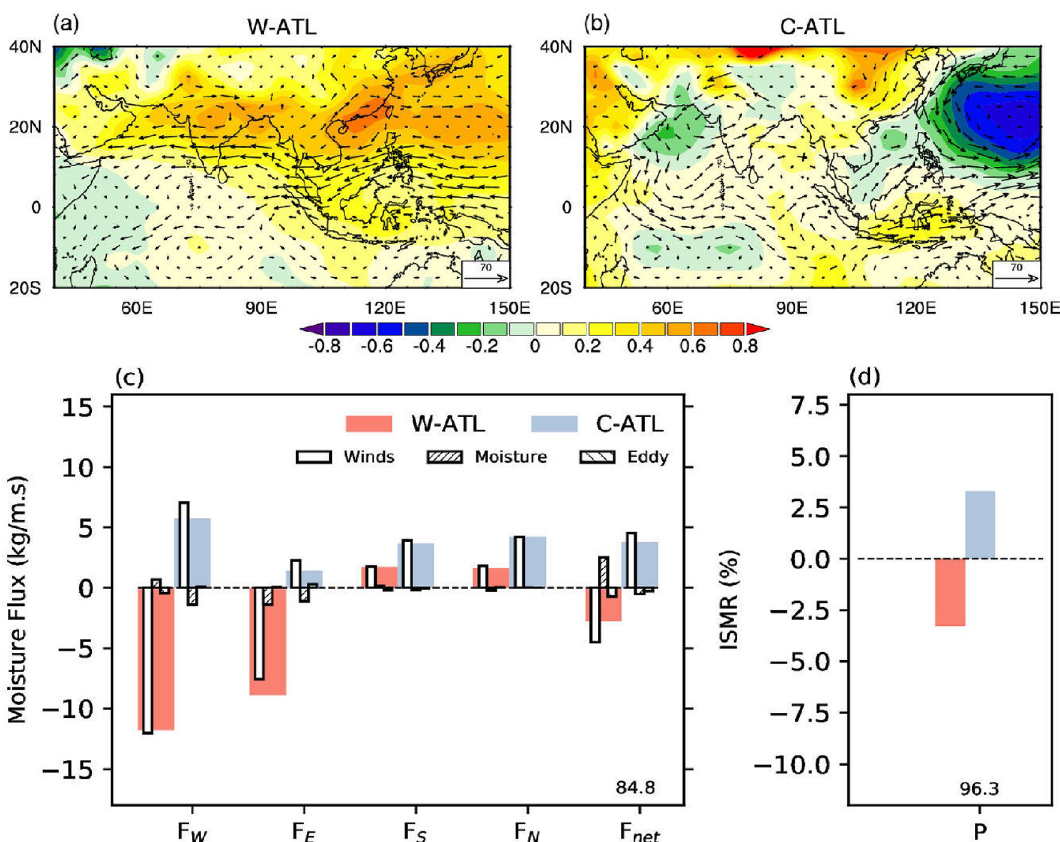
Figure 5. The teleconnection to tropical Atlantic variability (ATL). Composite change in the anomalous surface pressure (hPa) and vertically integrated moisture flux vector ( kgm − 1 s − 1 ) during ( a ) warm (W-ATL) and ( b ) cold (C-ATL) phases of ATL. ( c ) Shows the vertically integrated moisture flux anomalies and its decomposition along the four boundaries (west ( F W ), east ( F E ), south ( F S ), and north ( F N )) and net moisture convergence ( F net ) over region marked as ABCD in Fig. 1a, for W-ATL (red) and C-ATL (blue) years. The contribution to total moisture ¯(cid:3) Vq (cid:4) (cid:5) ), and eddy flux ( (cid:2)(cid:3) V (cid:4) q (cid:4) (cid:5) ). ( d ) flux (solid fill) and its components: due to winds ( (cid:2)(cid:3) V (cid:4) ¯ q (cid:5) ), moisture ( (cid:2)